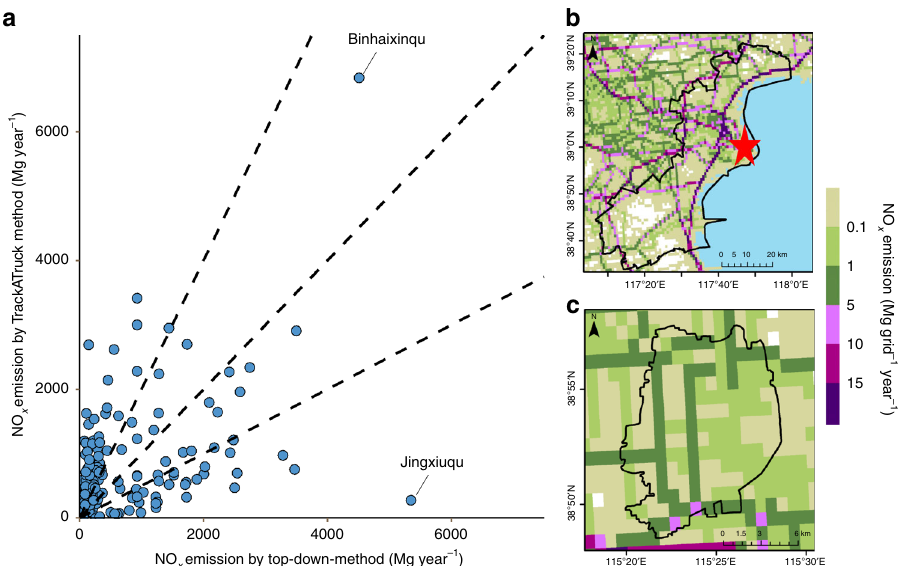
Fig. 2 Comparison of county emission inventories obtained by the TrackATruck method with the vehicle stock obtained based on the top-down method. a NO x emissions for 155 counties in the BTH region. b NO x emission map (0.01 ˚ × 0.01 ˚ ) for Binhaixinqu obtained using the TrackATruck method. The star symbol is the location of Tianjin port. c NO x emission map (0.01 ˚ × 0.01 ˚ ) for Jingxiuqu obtained using the TrackATruck method. *Source data are provided as a Source Data fi